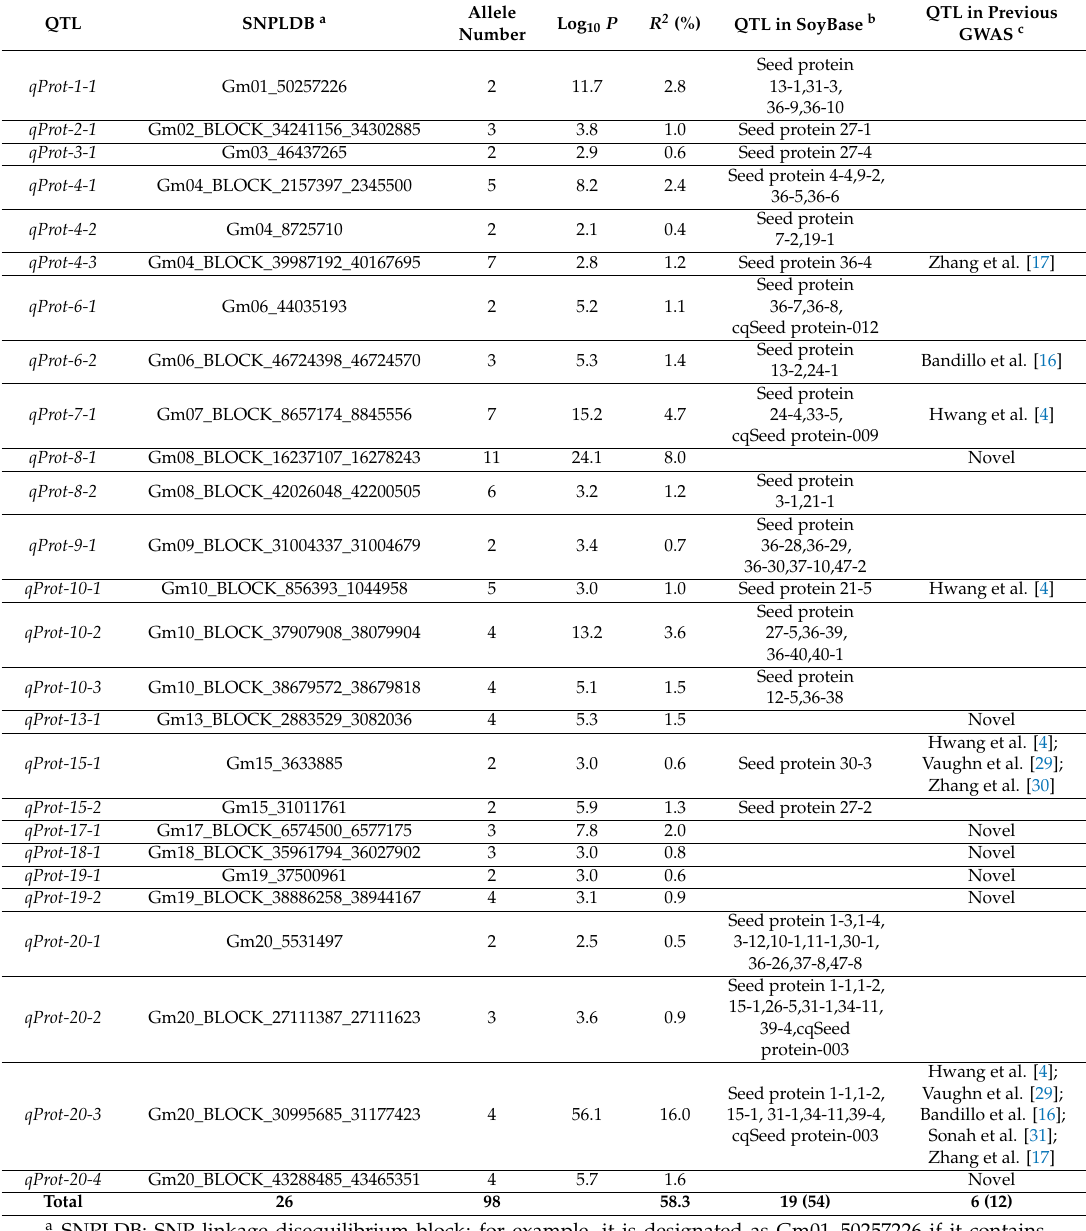
Table 2. Quantitative trait loci (QTLs) associated with the seed protein content detected in the soybean association